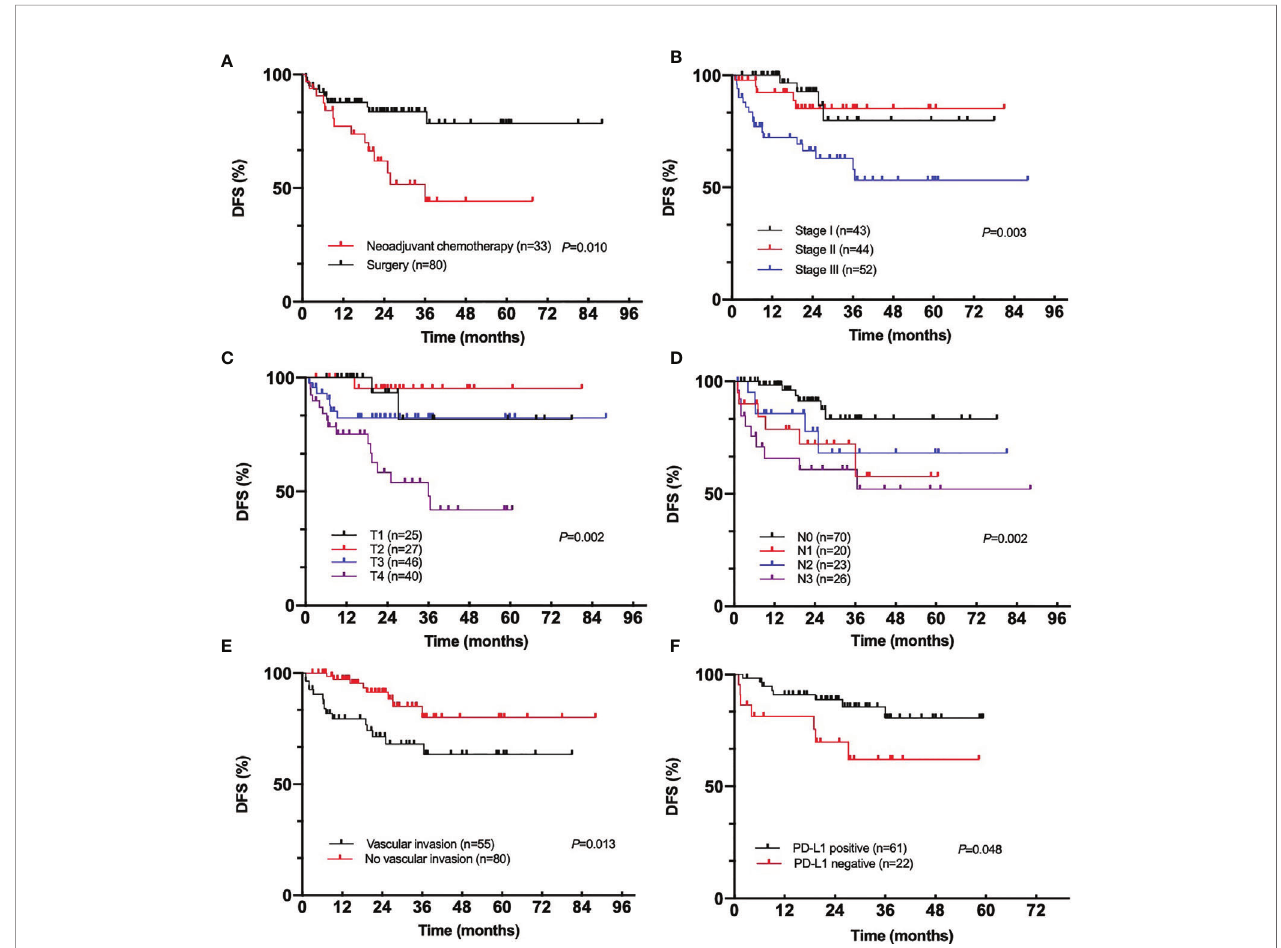
FIGURE 2 | DFS in different groups of EBVaGC: (A) , neoadjuvant chemotherapy; (B) , tumor stage; (C) , T stage; (D) , N stage; (E) , vascular invasion; (F) , PD-L1 expression.